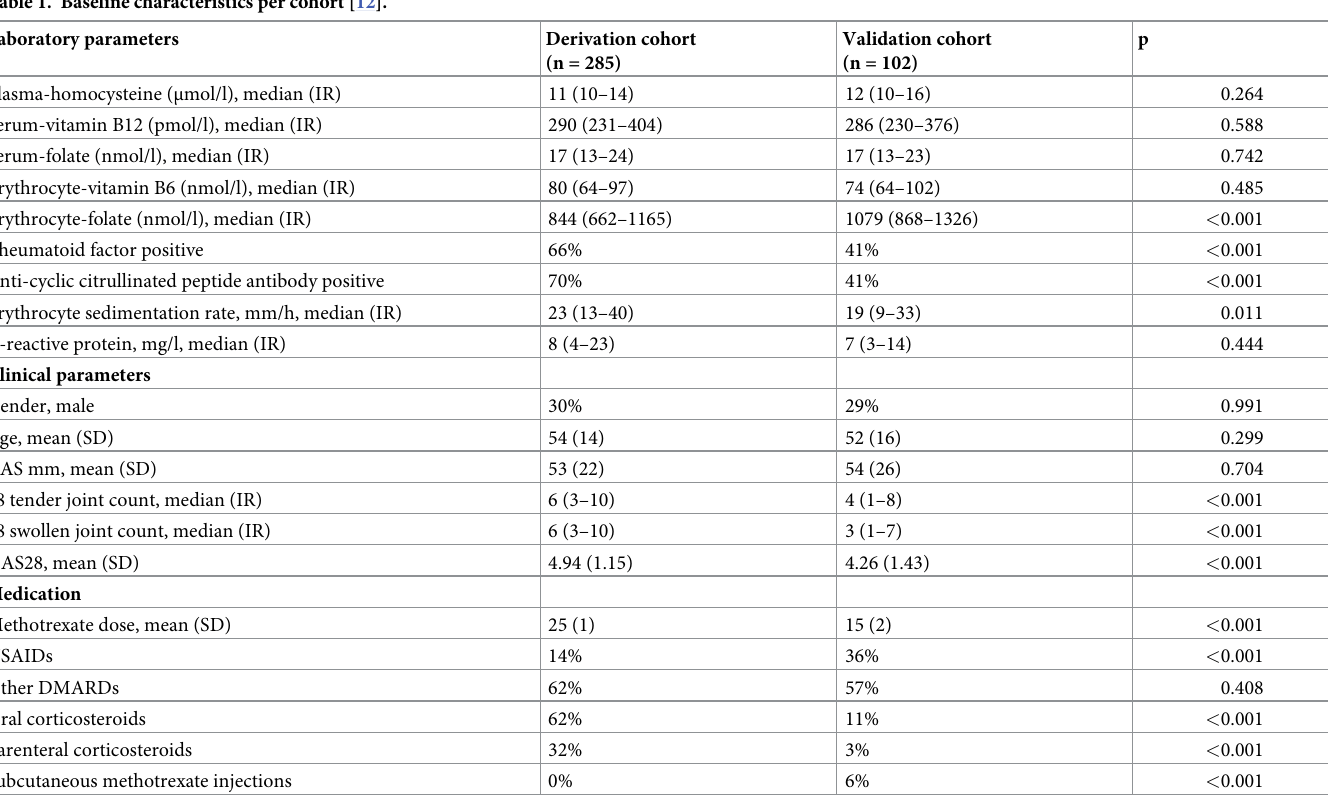
Table 1. Baseline characteristics per cohort